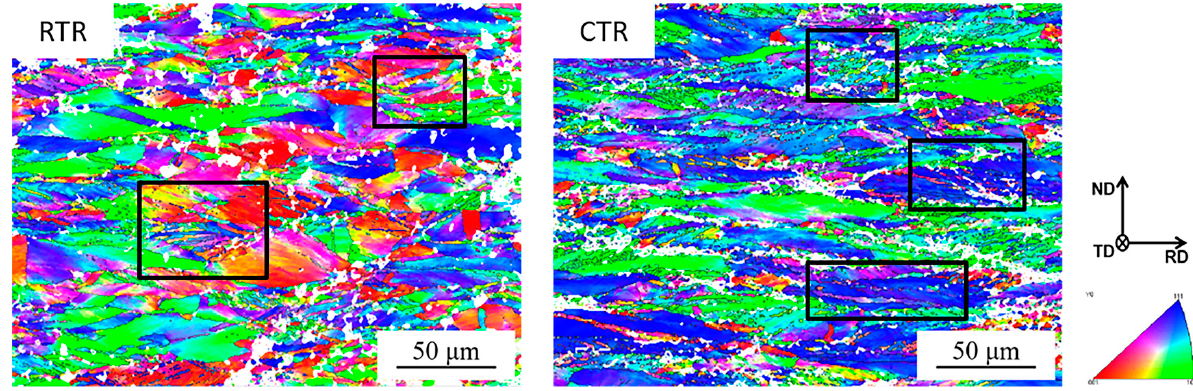
Figure 6. IPF of RTR and CTR Cu-Ti-Cr-Mg alloy with a rolling reduction of 60%. The distribution of grain sizes of RTR and CTR samples with a rolling reduction of 60% is shown in Figure 7. After 60% deformation, the grains in both samples are broken into small sizes. The fraction of grains of the CTR sample with the sizes of 0.5 µ m is up to 55%, higher than that of the RTR sample. The average grain sizes of RTR and CTR samples are 1.58 µ m and 1.27 µ m,